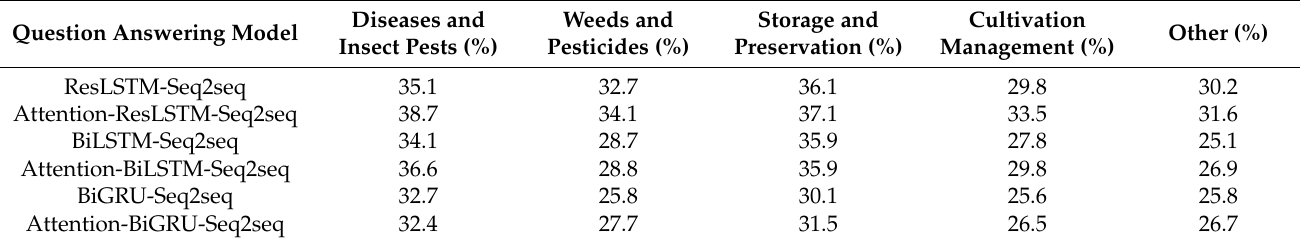
Table 7. BLEU and ROUGE of different models and different types of rice-related Q&A pairs.